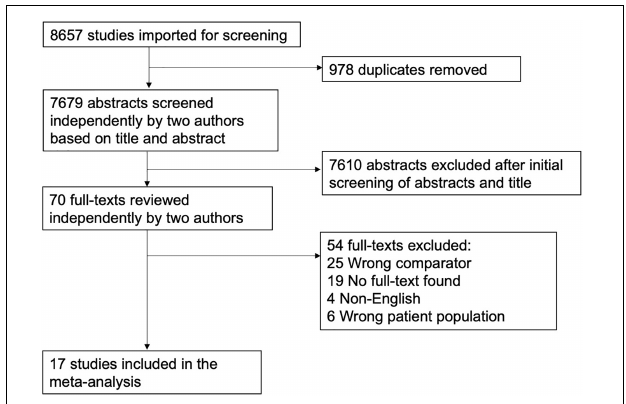
FIGURE 1 | Flow Diagram of the literature search and study selection. The flow diagram represents the number and reasons for elimination of studies at every step based on the selection